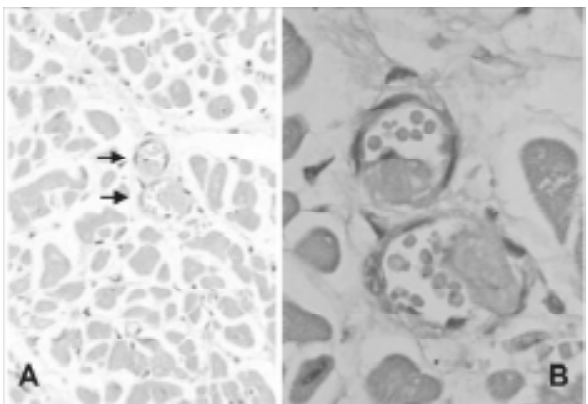
Figure 6. A. Microphotography of the myocardium adjacent to the coronary artery showing micro-thrombi occluding the myocardial capillaries. Also myocardial fibers without striations or nuclei, suggesting a process evolving to necrosis can be evidenced. (hematoxylin-eosin; 100X magnification). B. Magnification at 400X of the same specimen detailing the occluded myocardial